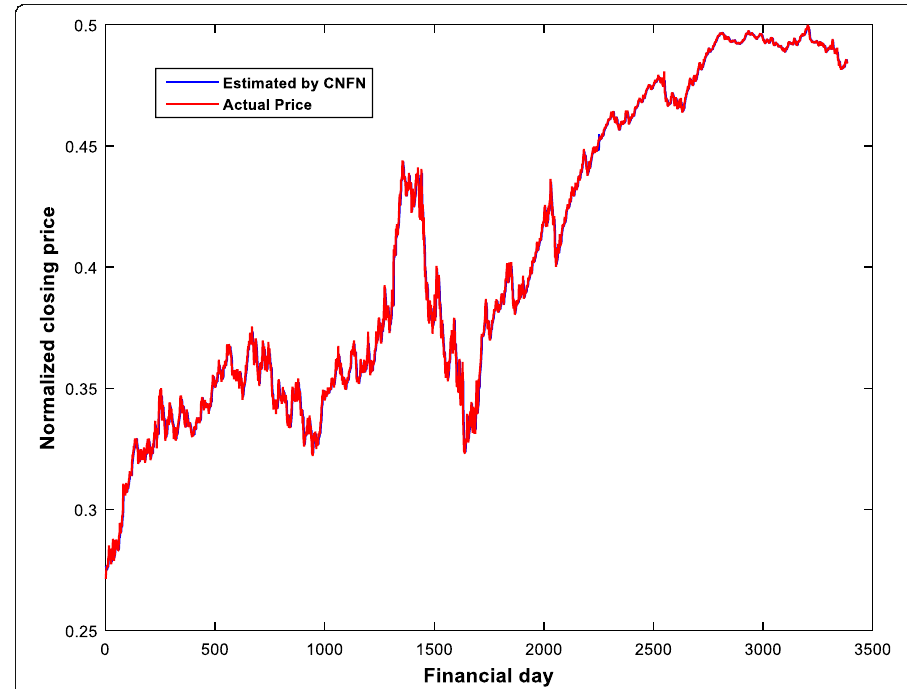
Fig. 16 Estimated v/s actual closing prices by CNFN forecasting model for BSE stock market data